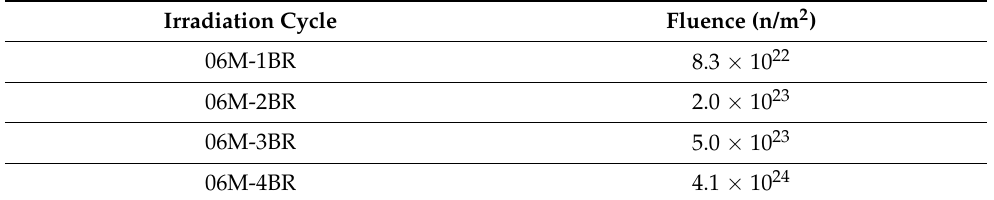
Table 2. Irradiation cycles and neutron fluence (n/m 2 ) used in the